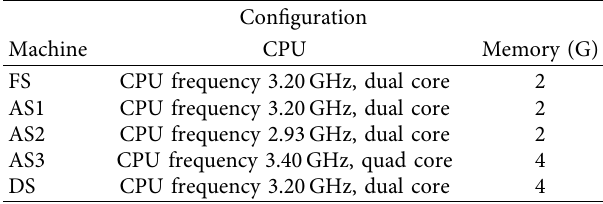
Figure 8: Average response time comparison of two containers. Table 4: Hardware configuration of test